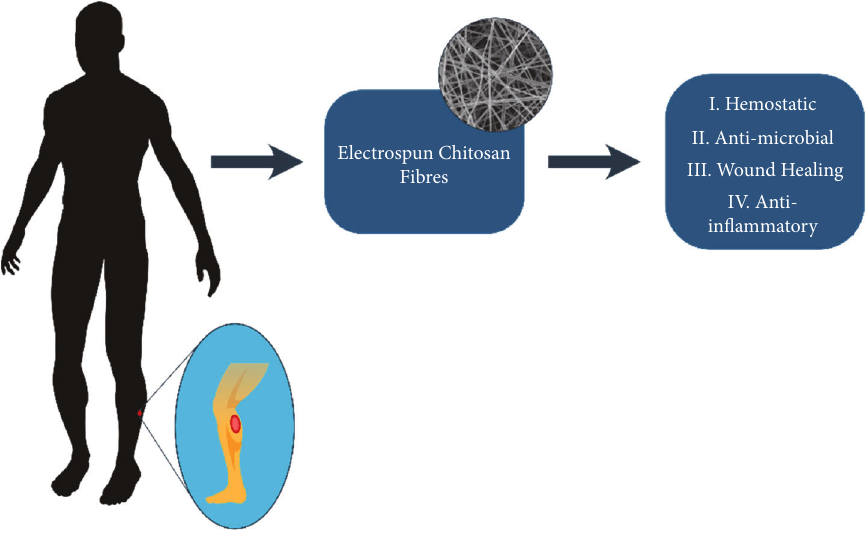
Figure 4: Application of electrospun chitosan fi bres in wound